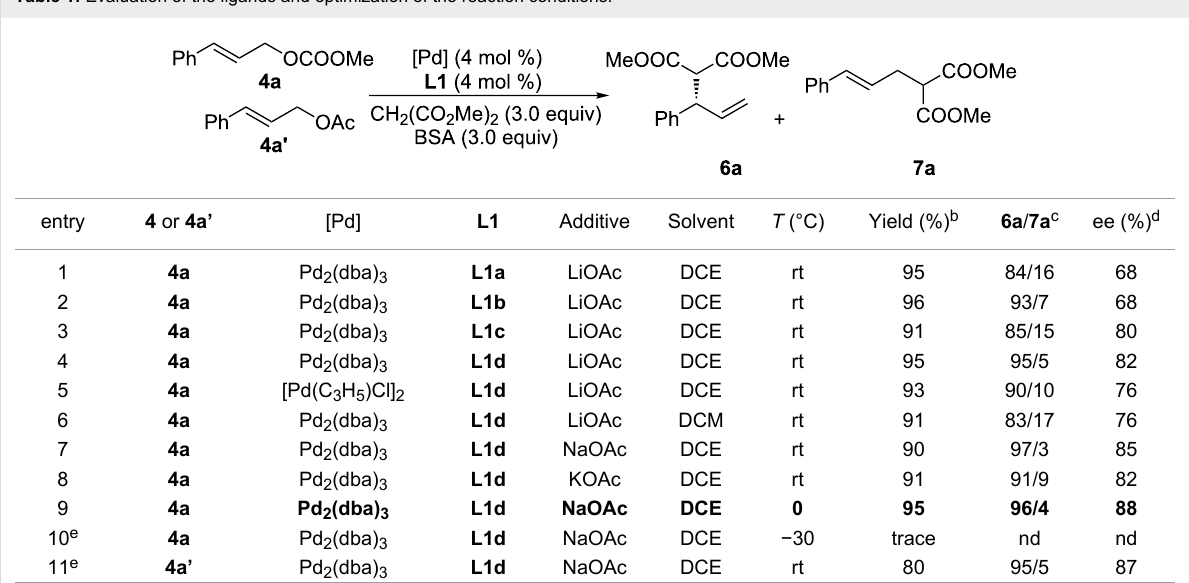
Table 1: Evaluation of the ligands and optimization of the reaction conditions.